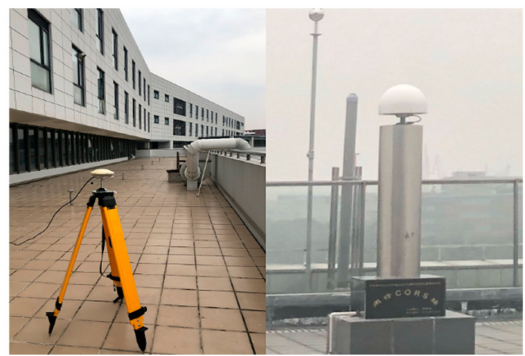
Figure 8. Surrounding environments of the rover station and reference